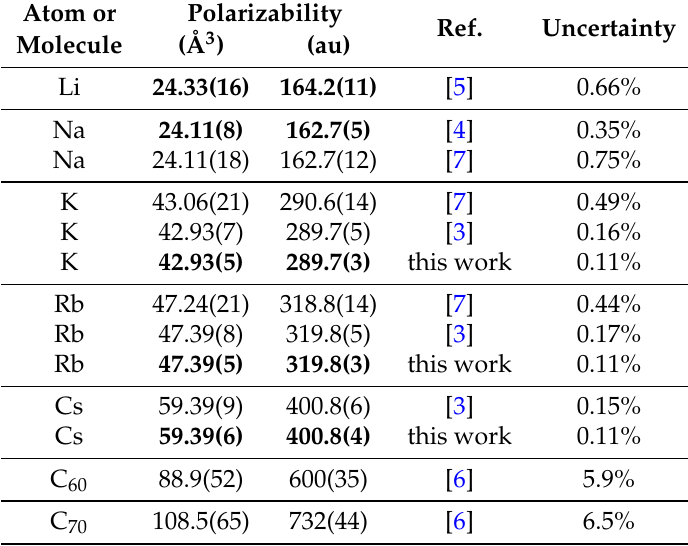
Table 1 lists polarizability measurements made with atom interferometry. For Li, Na, K, Rb, and Cs, atom interferometry has provided the best available measurements. Polarizability measurements made using other methods are reviewed in [13,42–46]. Table 1. Measurements of static polarizabilities α ( 0 ) made using atom or molecule